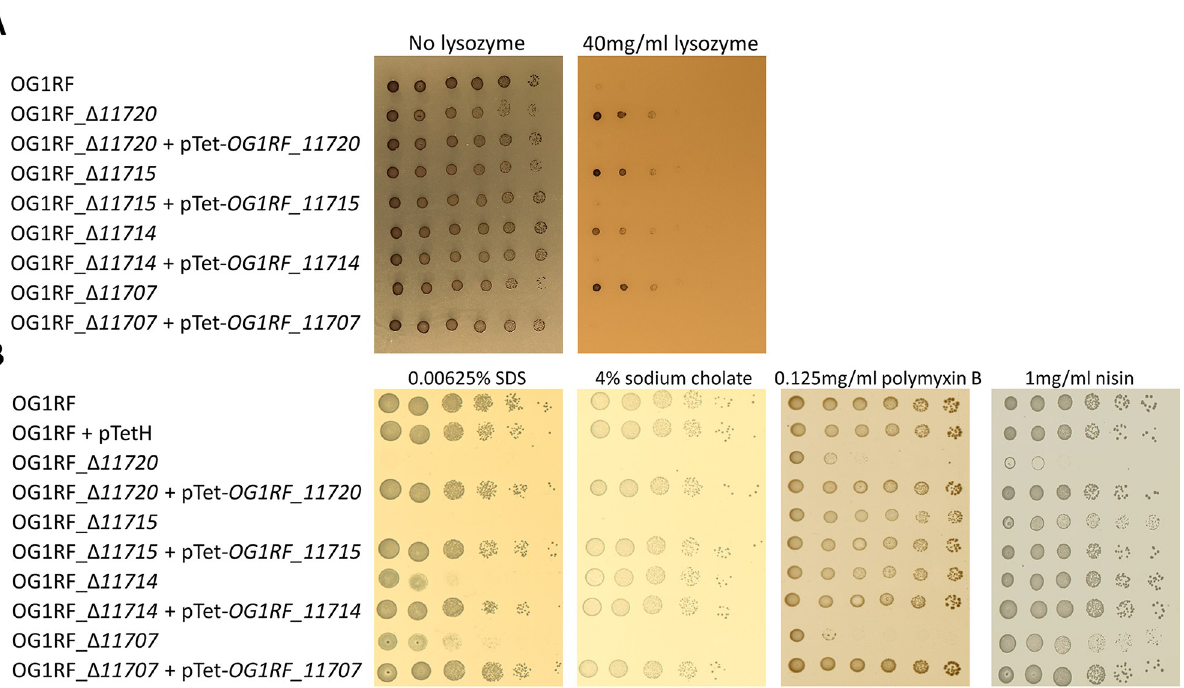
Fig 5. Growth defect of E . faecalis OG1RF in-frame epa mutants in the presence of antimicrobials targeting the cell envelope. Cell suspensions were prepared as described in S1 Fig and 1.5 μ l of serial dilutions were spotted on BHI-agar plates containing 10 ng ml -1 anhydrotetracycline and lysozyme ( A ), SDS, sodium cholate, polymyxin B or nisin ( B ). In the case of lysozyme, tellurite was added to the plate (20 μ g l-1) to increase the contrast of colonies. For each antimicrobial, one concentration showing a difference in susceptibility is shown.